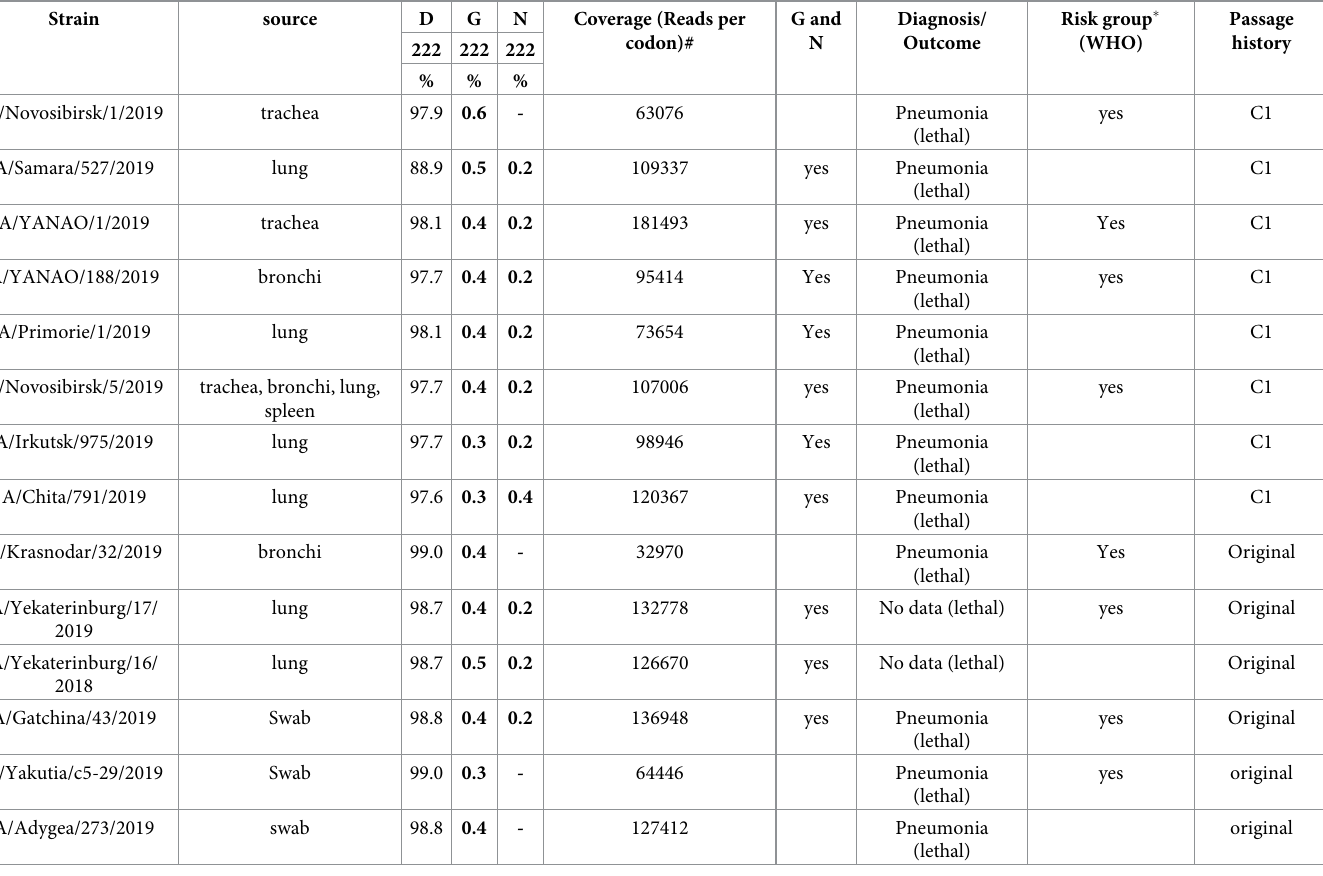
Table 3. Analysis of 222D/G/N polymorphism in samples of the A(H1N1)pdm09 virus (D222G/N mutations in the minor virus variants (0.2–0.6%)).